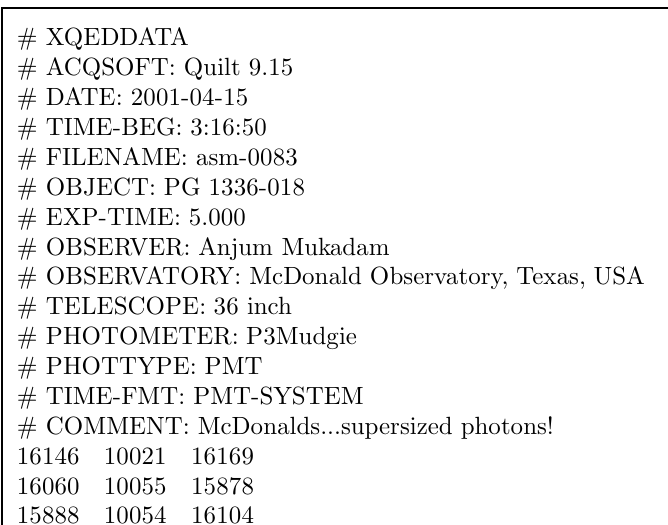
Table 5. The Quilt 9 file from Table 1 is reformat- ted into the new WET format and dis- played